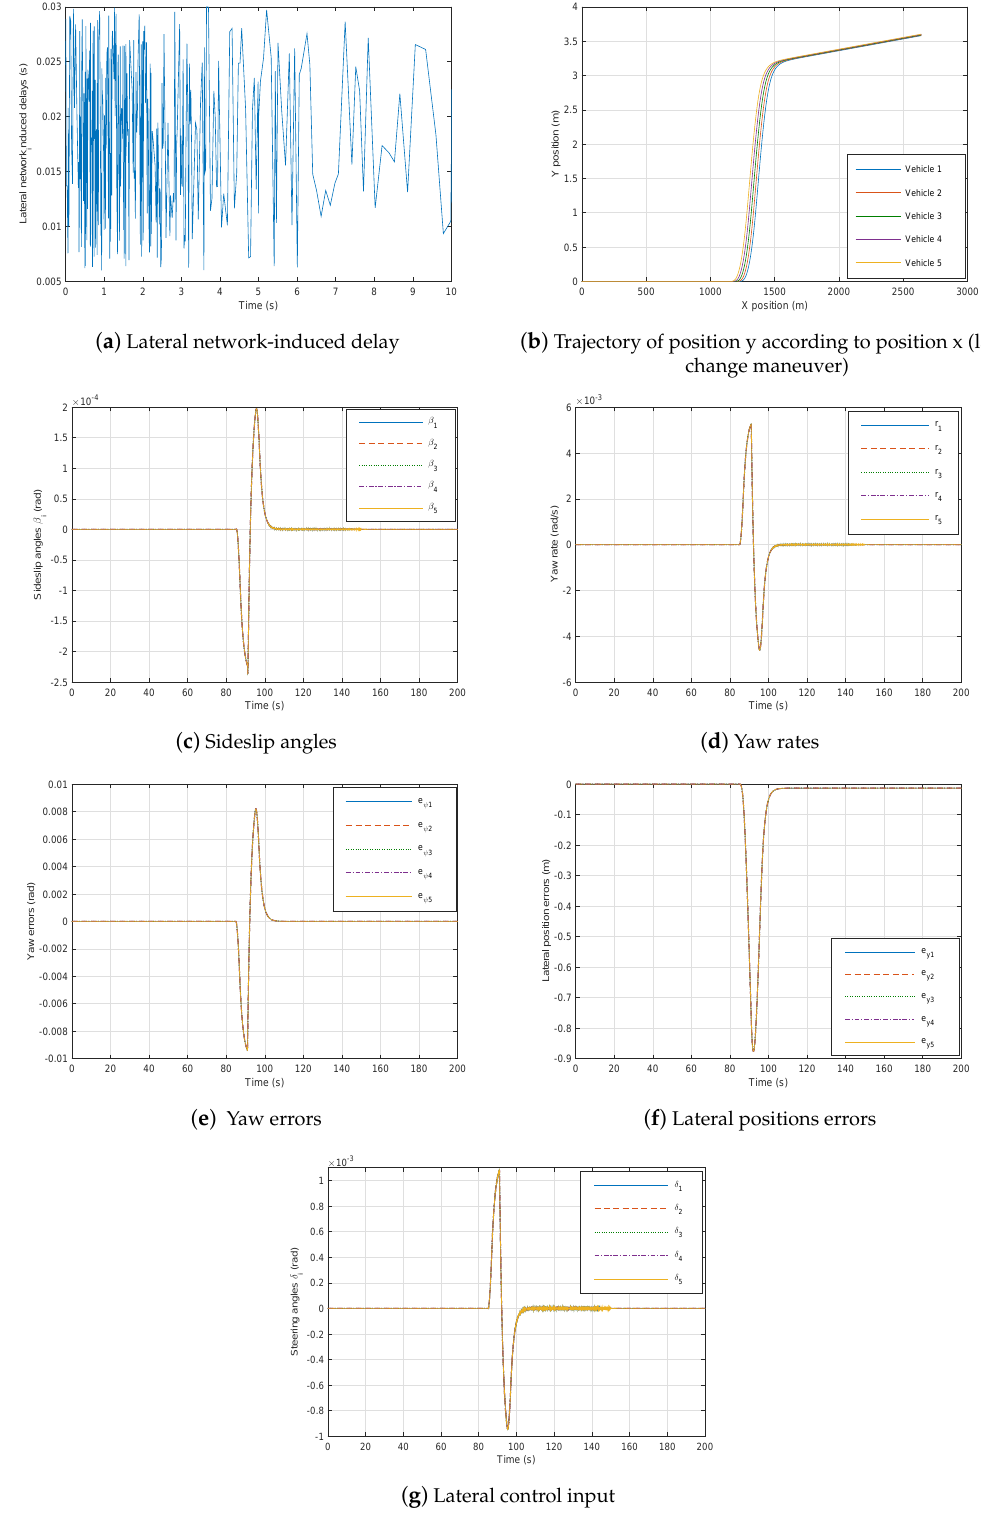
Figure 11. Six-vehicle platoon system under controller (50) through the communication